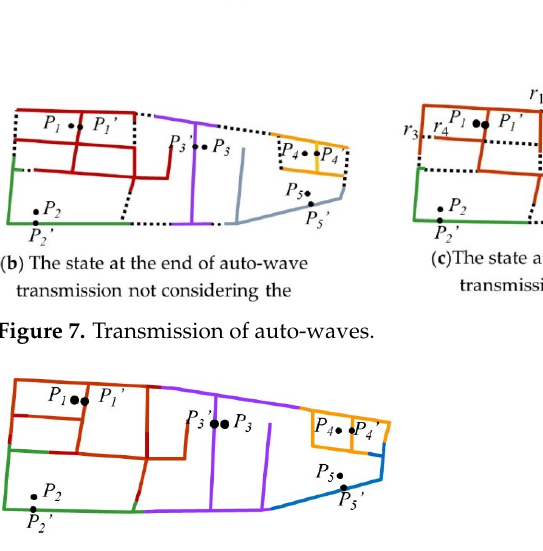
Figure 8. The final state of auto-wave transmission.